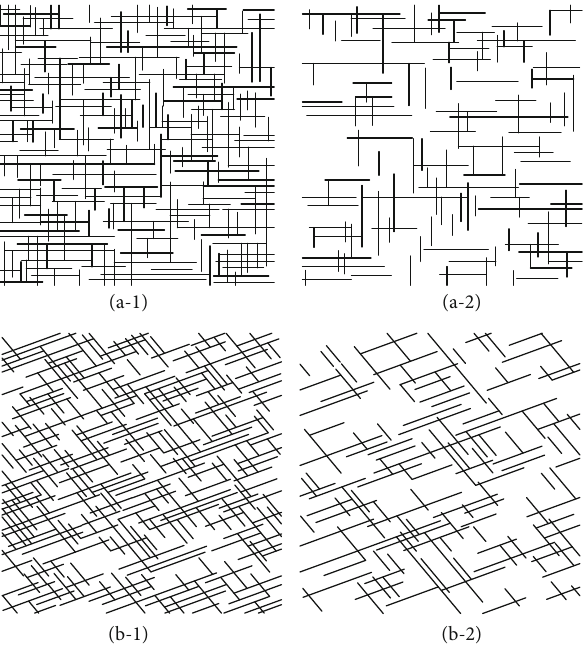
Figure 1: Four fracture networks generated by the MATLAB